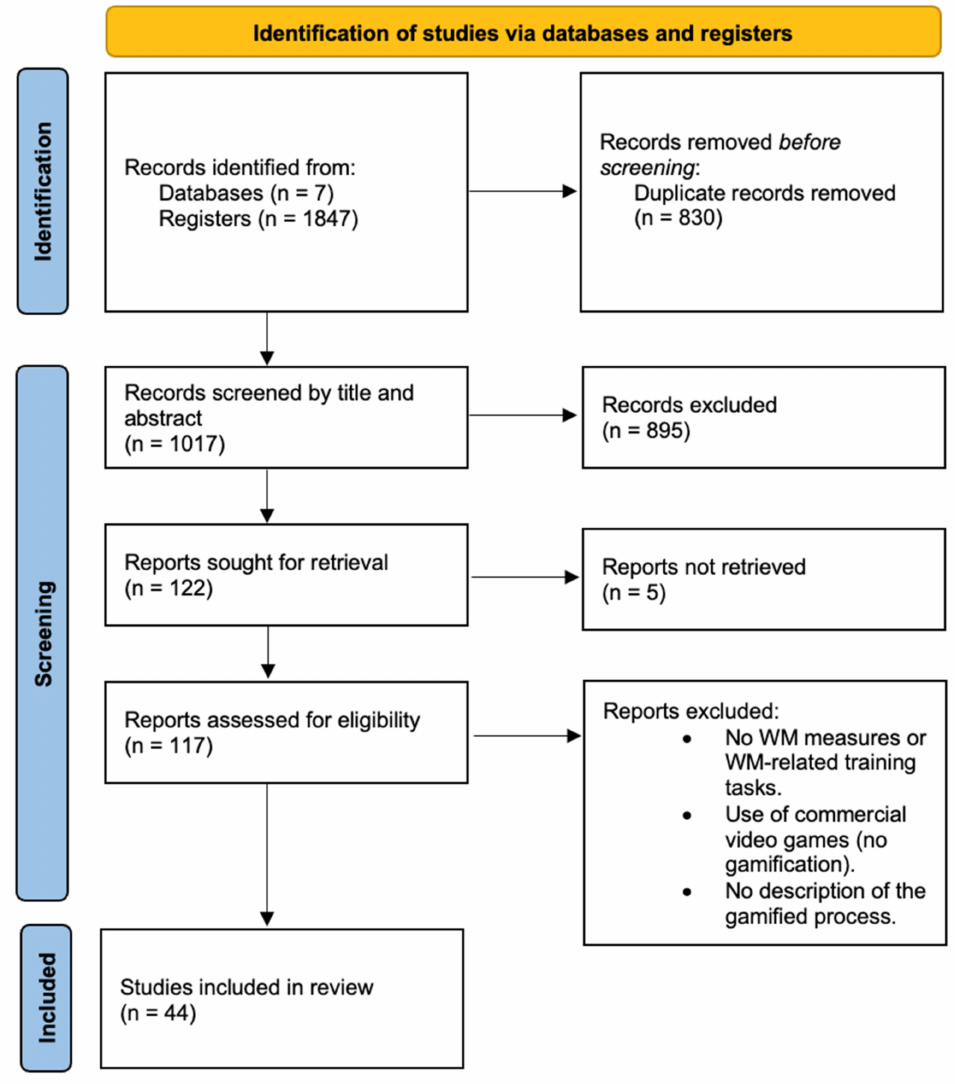
Figure 1. PRISMA flow